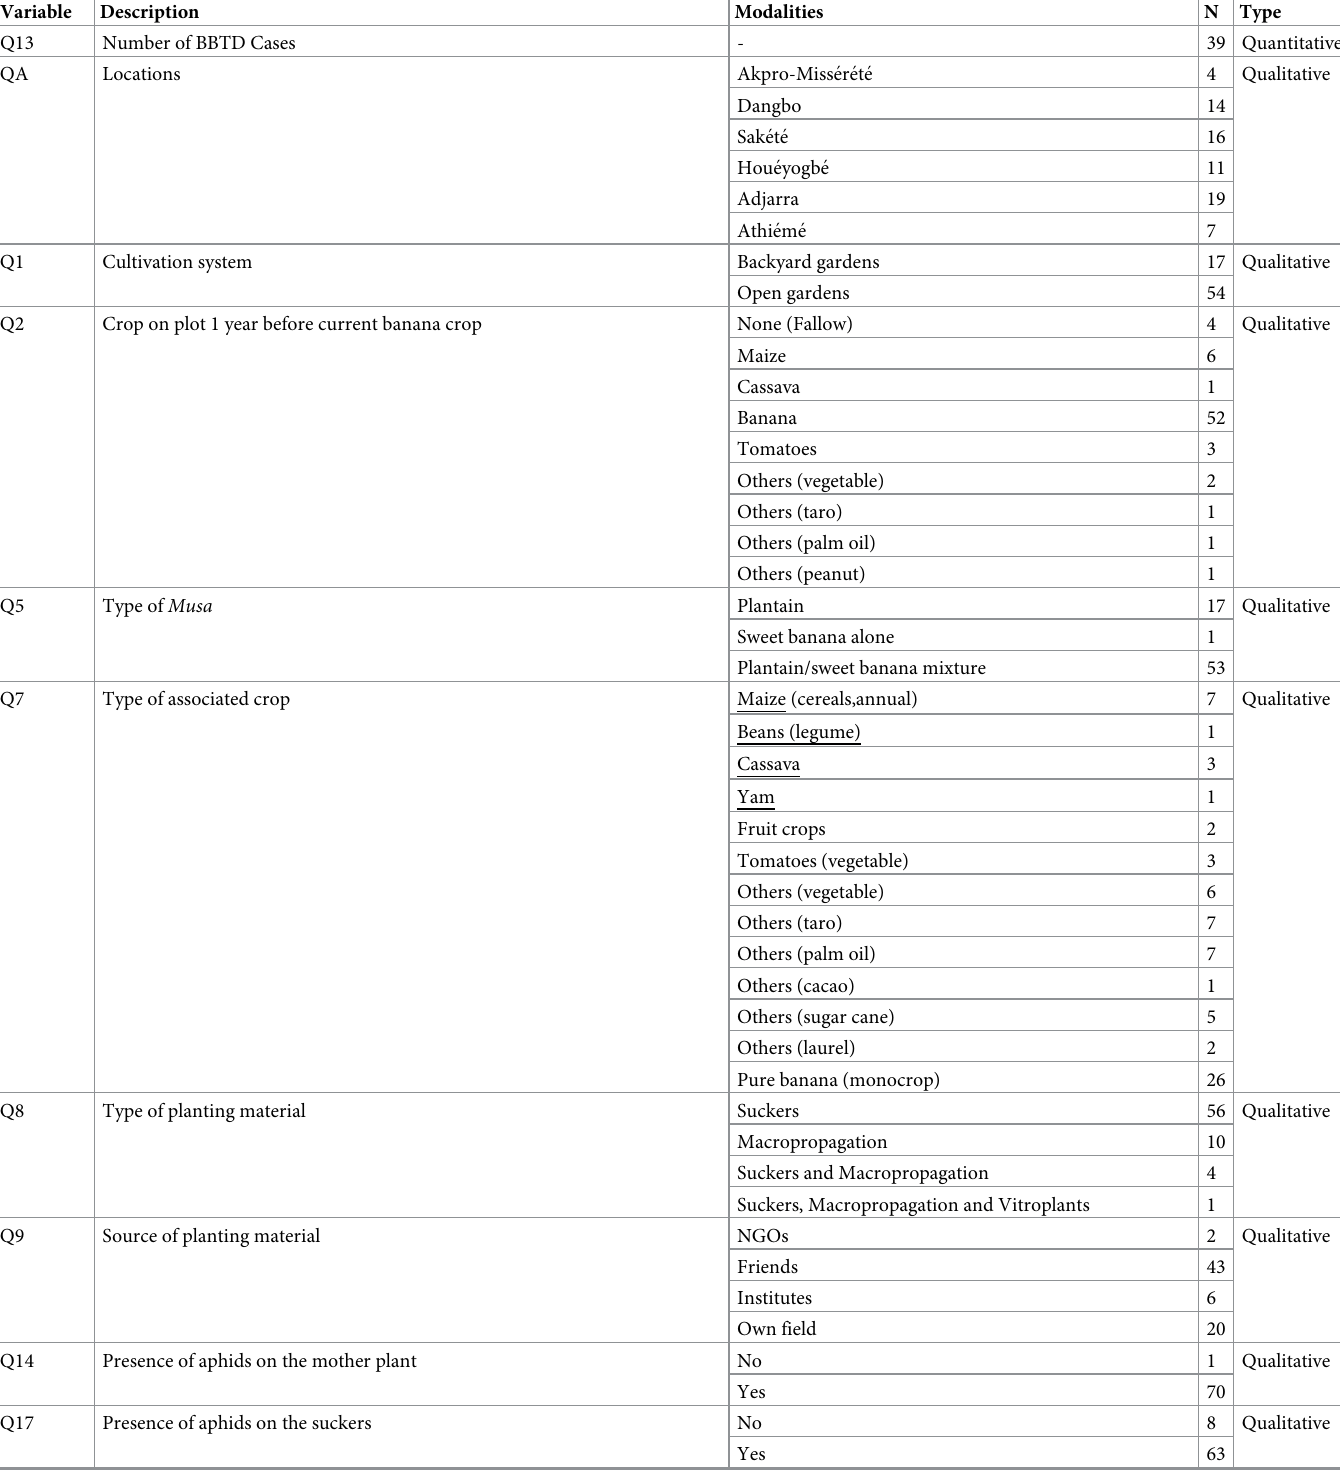
Table 1. Presentation of Poisson regression